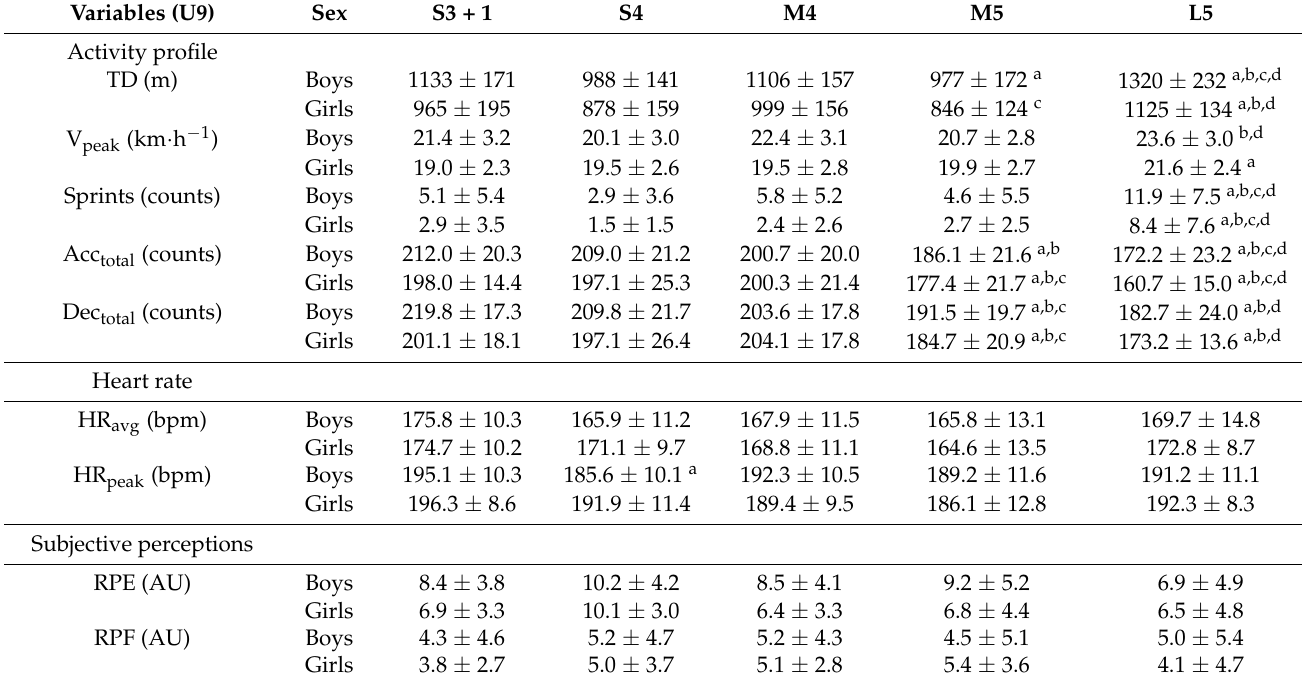
Table 1. Differences in peak and average values and total distance between game formats.